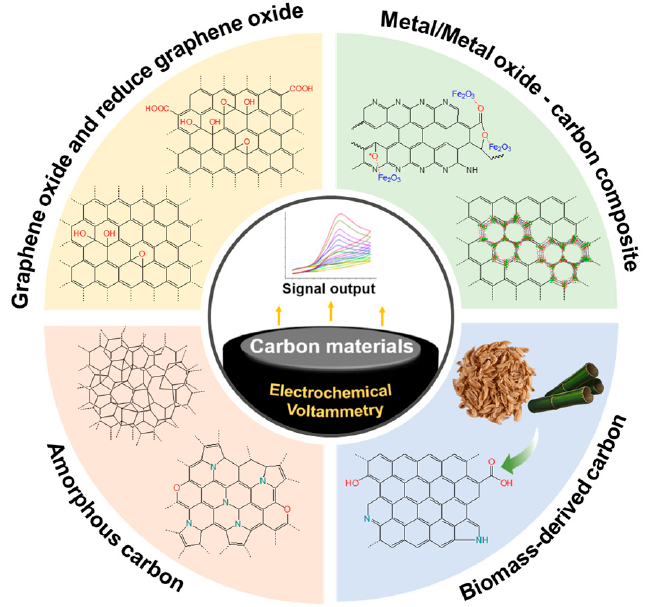
Figure 1. Carbon materials are commonly used to construct electrochemical voltammetry